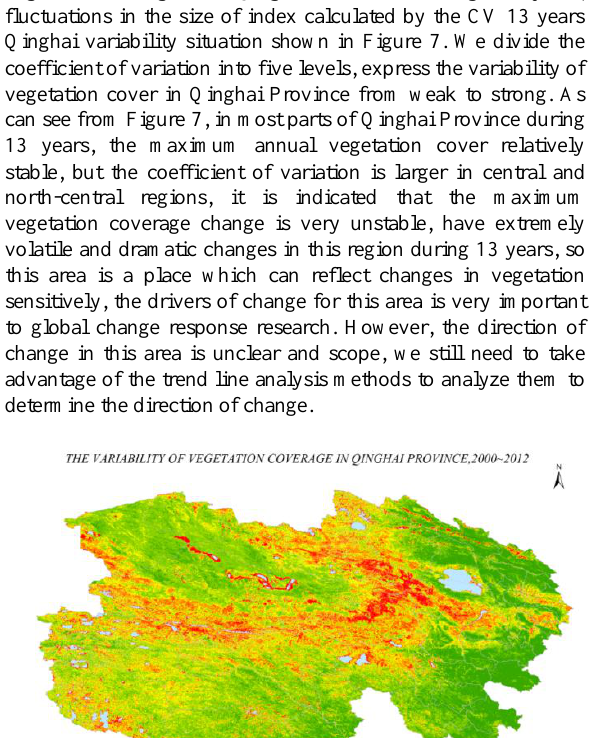
Table 3. The change trend statistics of vegetation coverage during the period from 2000 to 2012 in Qinghai